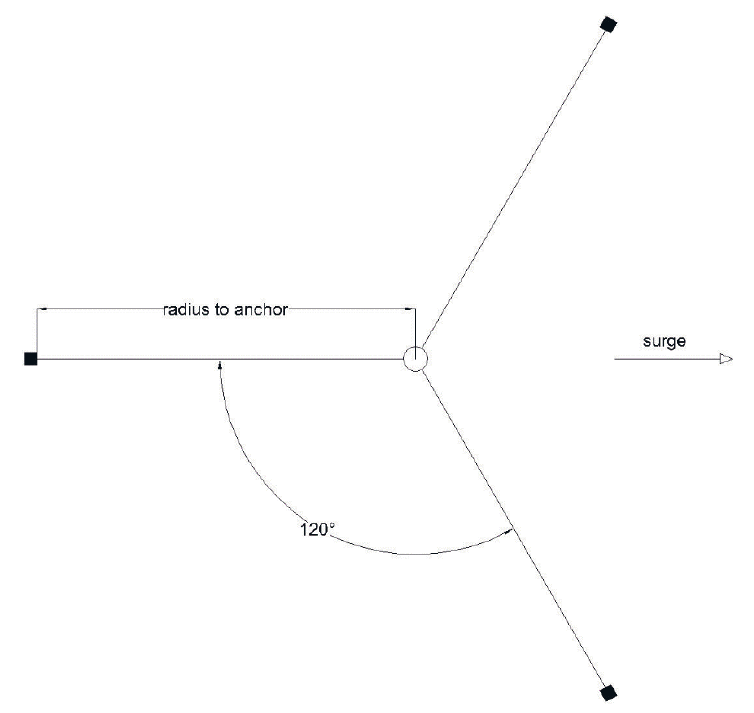
Figure 9. Mooring system